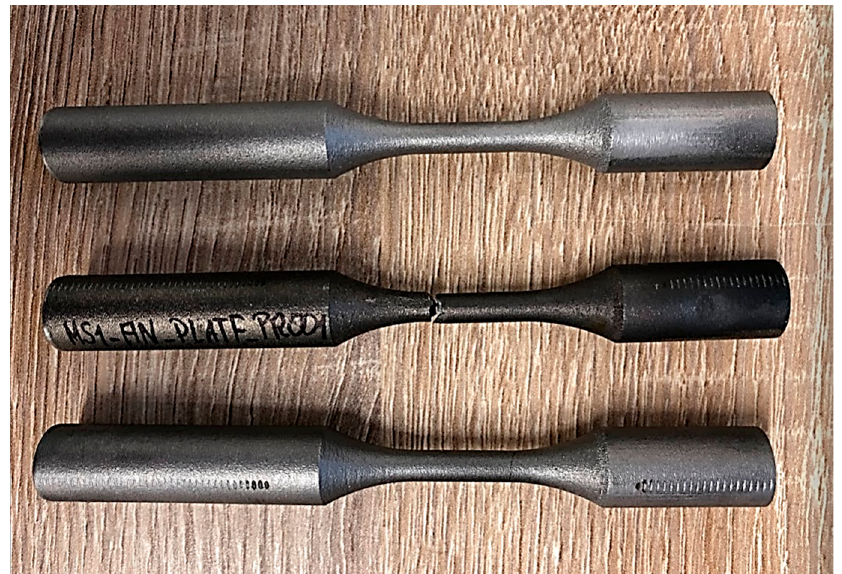
Figure 4. Photograph of test specimens before and after axial fatigue testing, OUTech Opole.